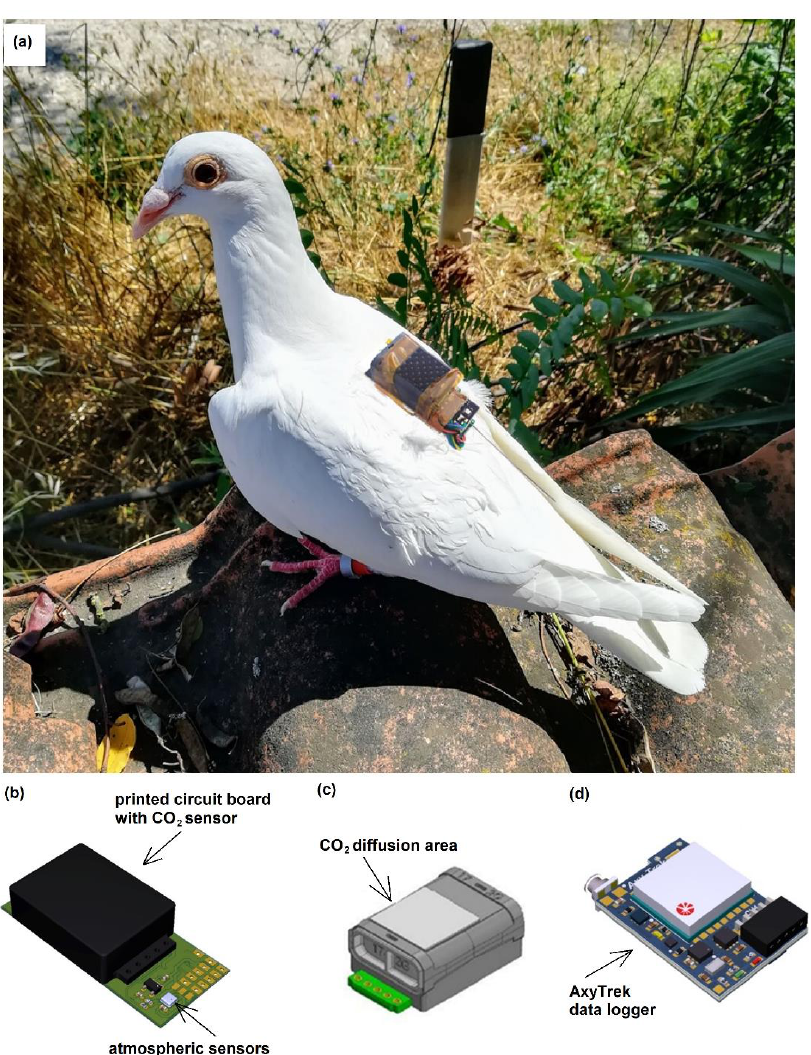
Figure 1. Photograph of the device attached on a homing pigeon ( a ), schematic view of printed circuit board with CO 2 and atmospheric sensors ( b ), CO 2 sensor (Senseair Sunrise, Senseair AB, Delsbo, Sweden) with the gas diffusion area represented by the white membrane ( c ), and AxyTrek data logger ( d